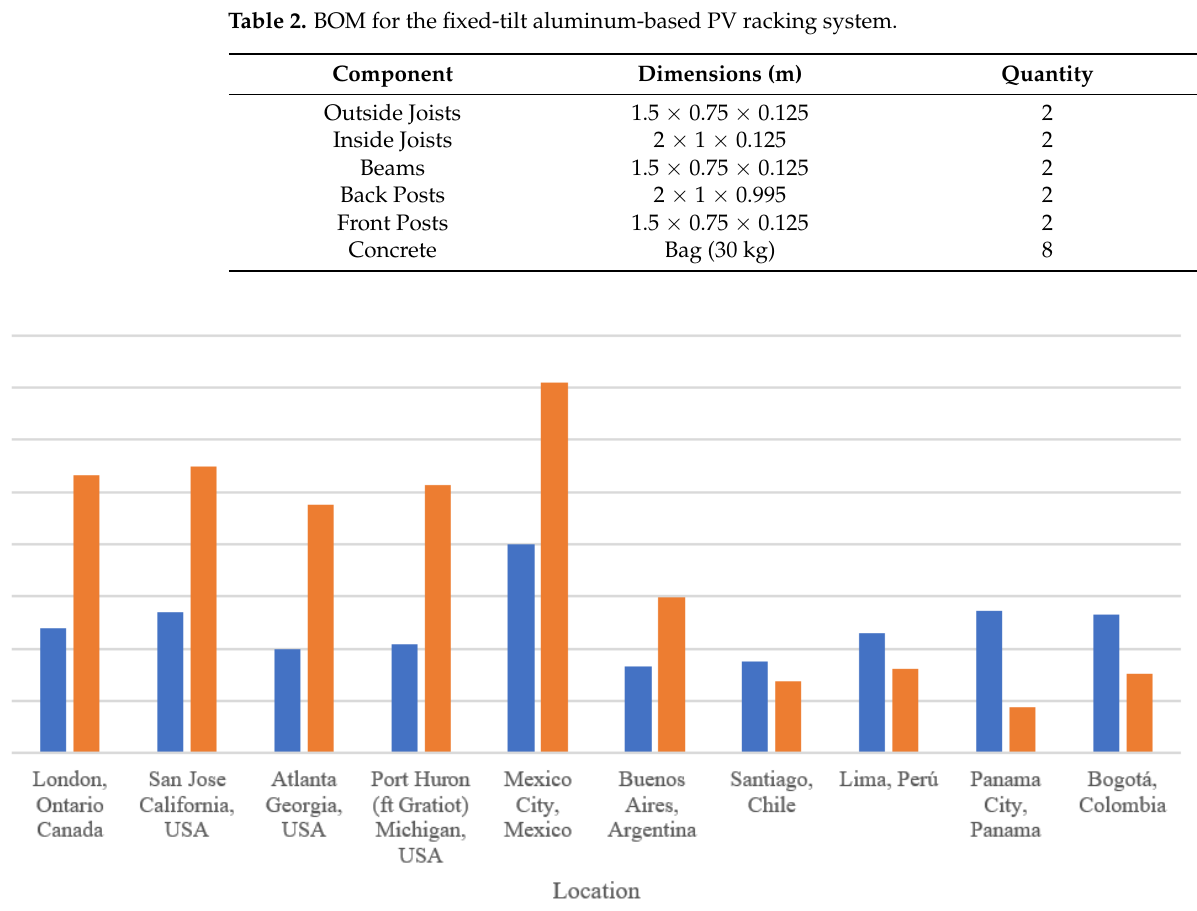
Figure 2. The capital costs of the BOM for the open hardware PV racks for both wood and aluminum are shown in ten cities/countries. Blue is the cost of the wood racks and orange is the cost of aluminum racks. Table 1. Simplified BOM for the fixed-tilt wood-based PV racking system.